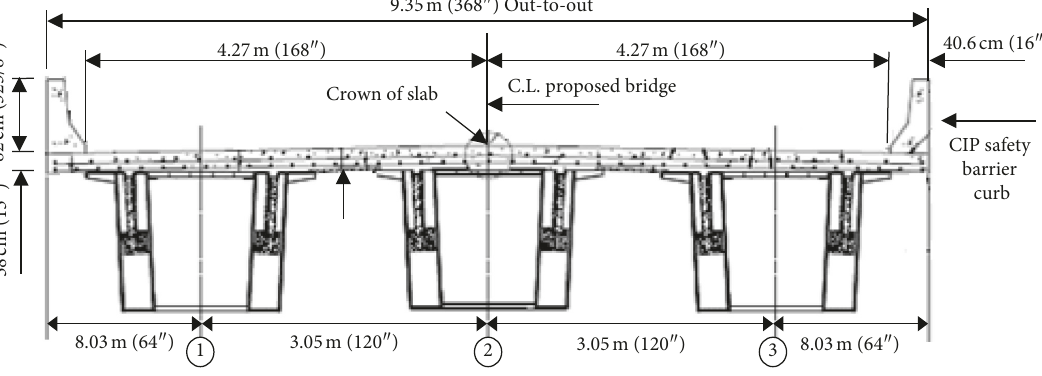
Figure 1: Typical cross section of bridge 0410.